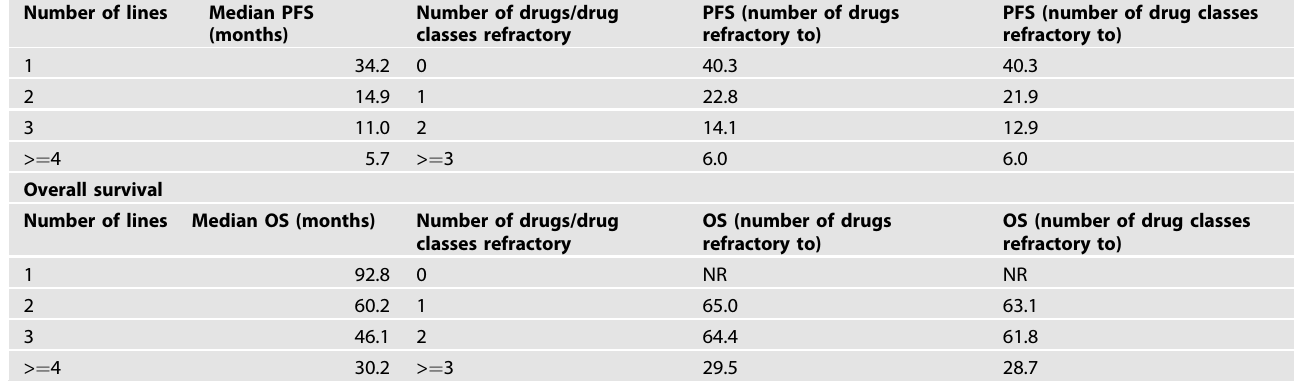
Table 1. Classi fi cation based on refractoriness to the number of drugs/drug classes vs lines of therapy. Number of lines Median PFS (months)